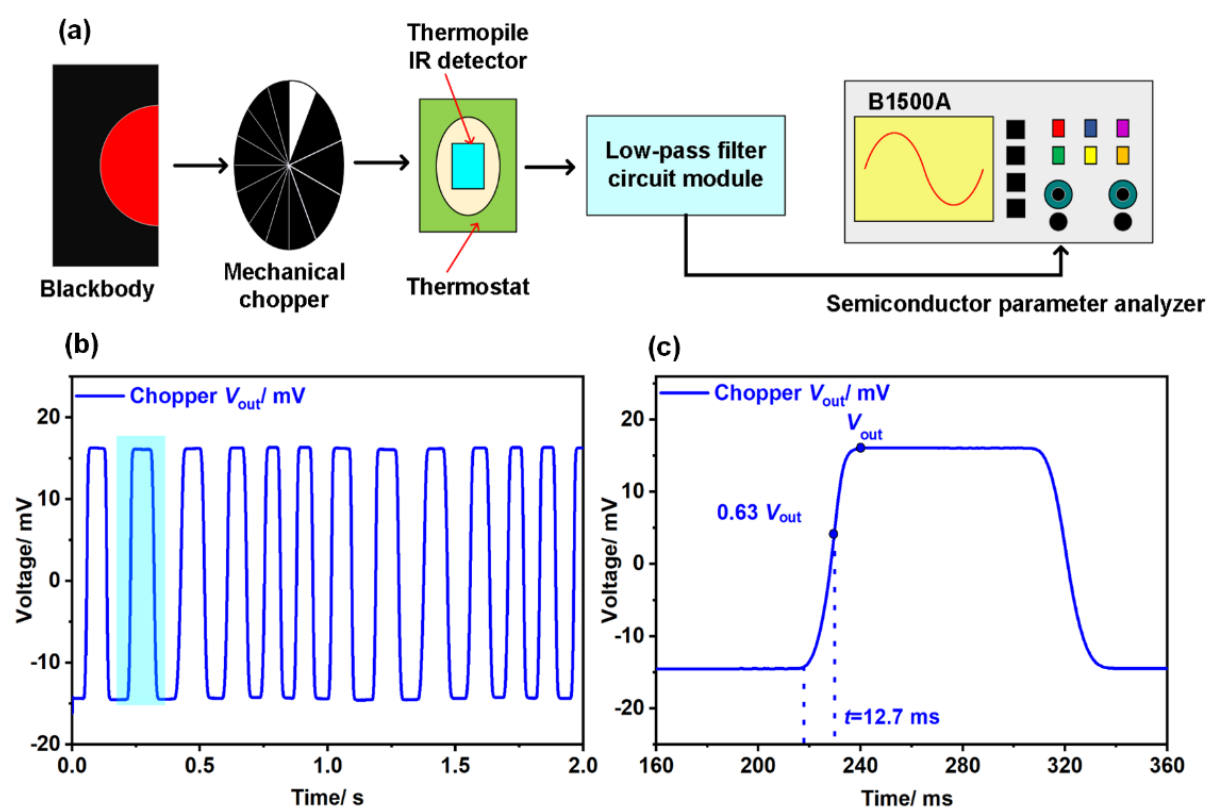
Figure 6. ( a ) Schematic diagram of a chopper—based measurement system; ( b ) output waveform of multiple cycles obtained by the chopper—based system; ( c ) a single cycle demonstrating the response time of the